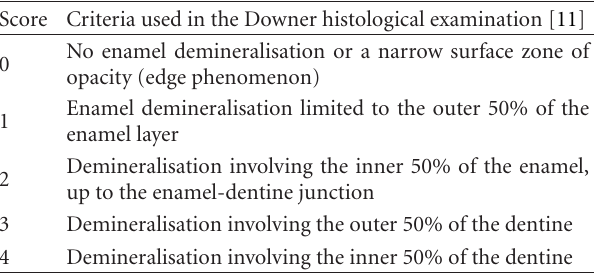
Table 2: Criteria used in the histological examinations. Score Criteria used in the Downer histological examination [11]